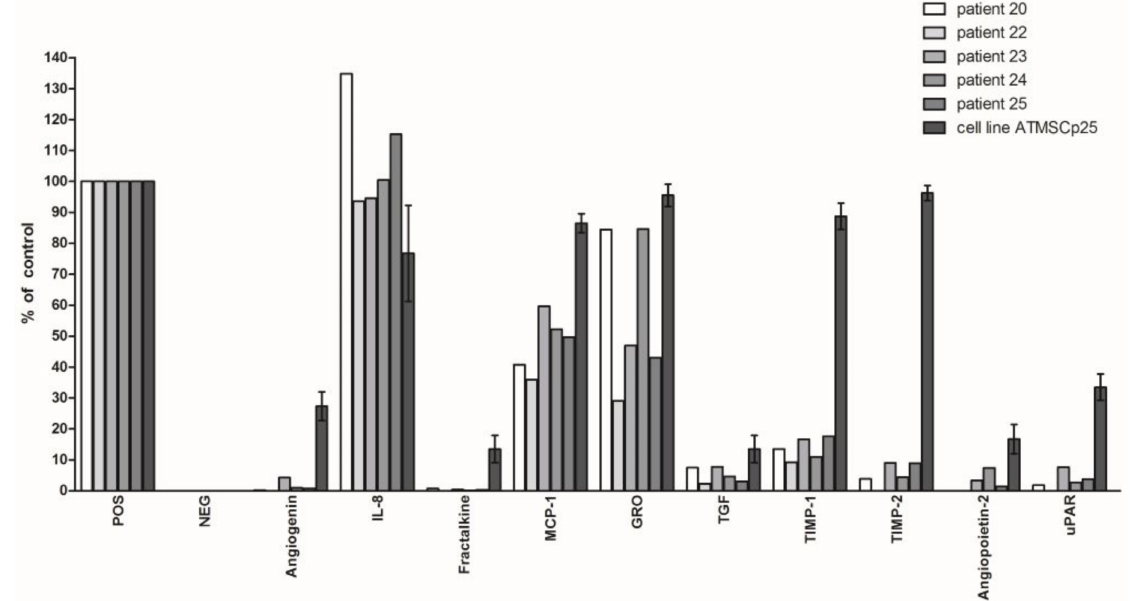
Figure 4. Secretion of cytokines by primary MSCs from the adipose tissue of patients and immortalized HATMSC1 cell line. Secretion of cytokines was evaluated using RayBio ® Custom C-series Human Cytokine Antibody Array for a panel of 50 cytokines and expressed as a histogram relative to a positive control. Cell cultures were established with the same number of cells from patients and an established cell line. The data represent the mean from a duplicate of assessment for each patient +SEM from cell line.